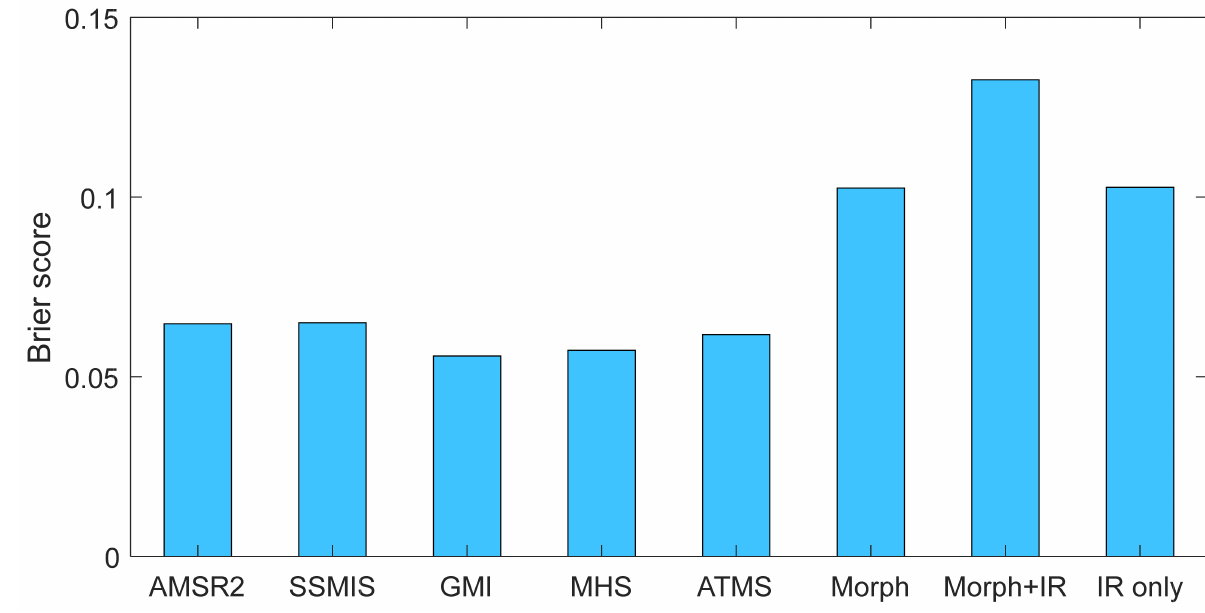
Figure 6. The Brier score for each input source used in